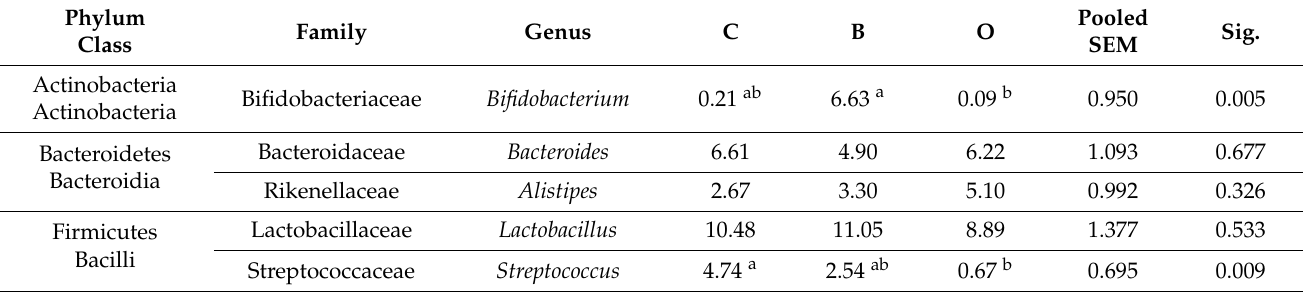
Figure 3. Boxplots showing significant changes in the genera of the jejunum mucosa. C: Control: maize-based diet; B: barley-based diet; O: oat-based diet. Results of Kruskal–Wallis test and the post hoc Dunn’s multiple comparisons test with Bonferroni correction. a,b values marked with different lowercase letters were significantly different ( p < 0.05). Results between 0.05 and 0.1 (0.05 < p < 0.10) were considered as a trend ( T ). Dots represent the outlier values. Table 7. Relative abundance of bacterial genera in cecum content of broiler chickens as affected by dietary treatments (%).